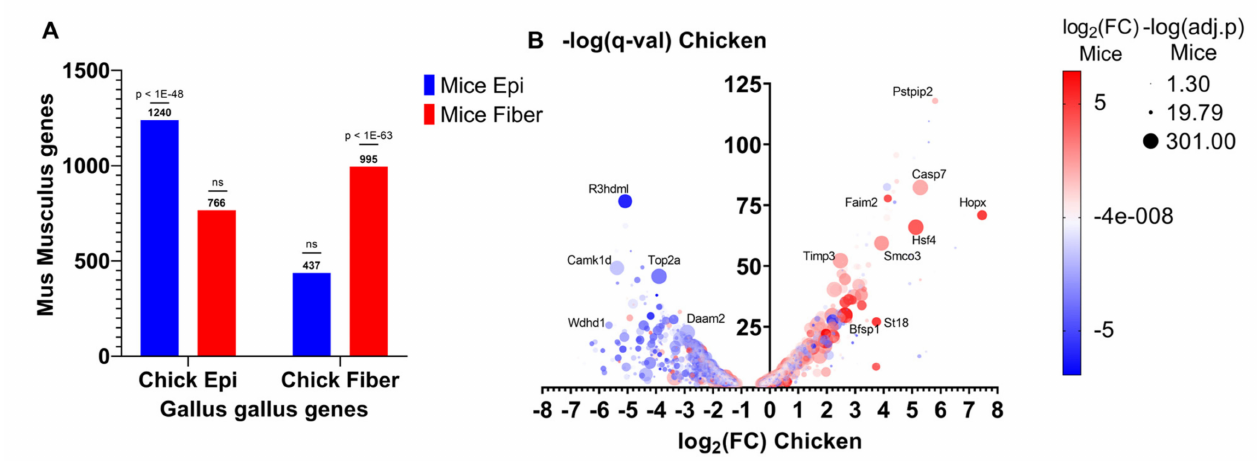
Figure 5. Lens differentiation-state-specific gene expression patterns are conserved between chicken and mice. ( A ) The number of Gallus gallus (chicken) genes classified as epithelial cell or fiber cell genes in E13 microdissected chicken lenses that were also classified as epithelial or fiber cell genes in E16.5 microdissected Mus musculus (mice) lenses. Epithelial cell genes are those more highly expressed in epithelial cells compared to fiber cells (log2FC < 0, q < 0.05). Fiber cell genes are those more highly expressed in fiber cells compared to epithelial cells (log2FC > 0, q < 0.05). ( B ) Volcano plot showing the genes that are differentially expressed between lens epithelial and fiber cells in E13 microdissected chicken lenses. The X-axis shows the log2FC expression level differences between fiber cells (log2FC > 0) and epithelial cells (log2FC < 0). The Y-axis shows the − log(q-val) of the significantly differentially expressed genes. Red dots indicate the genes that are also more highly expressed in lens fiber cells from E16.5 microdissected mice lenses. Blue dots indicate those that are more highly expressed in lens epithelial cells from E16.5 microdissected mice lenses. The size of the dot indicates the − log10(q-value) of significantly differentially expressed genes from microdissected mice